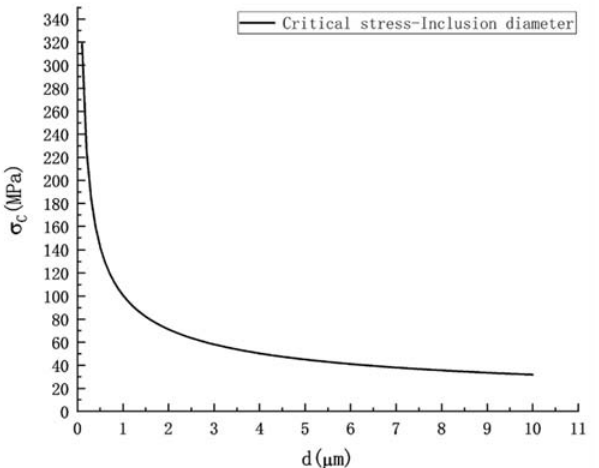
Figure 9. Relationship between inclusion size and critical cracking stress.